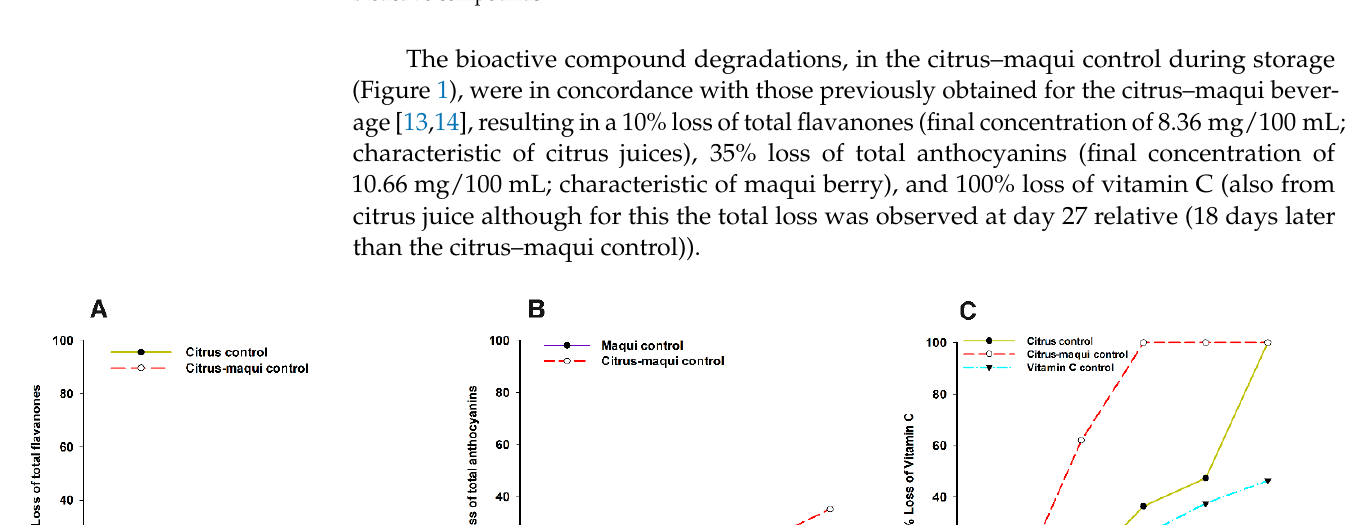
different bioactive compounds.